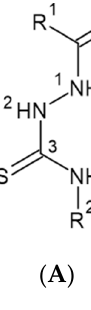
Figure 1. The general structure of thiosemicarbazide ( A ) and 1,3,4-thiadiazole ( B ) derivatives.